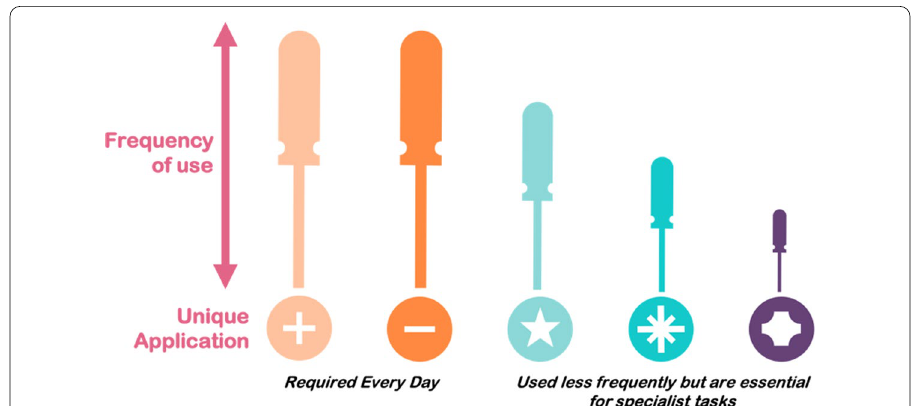
Fig. 13 The screwdriver analogy. All tools are essential for the task they perform irrespective of how frequently that task is performed; the same is true for radiopharmaceuticals and therefore [ 18 F]AlF and 68 Ga radioconjugates both have an important role to play in modulating supply to meet the clinical demand for a range of imaging probes to offer patients the best possible